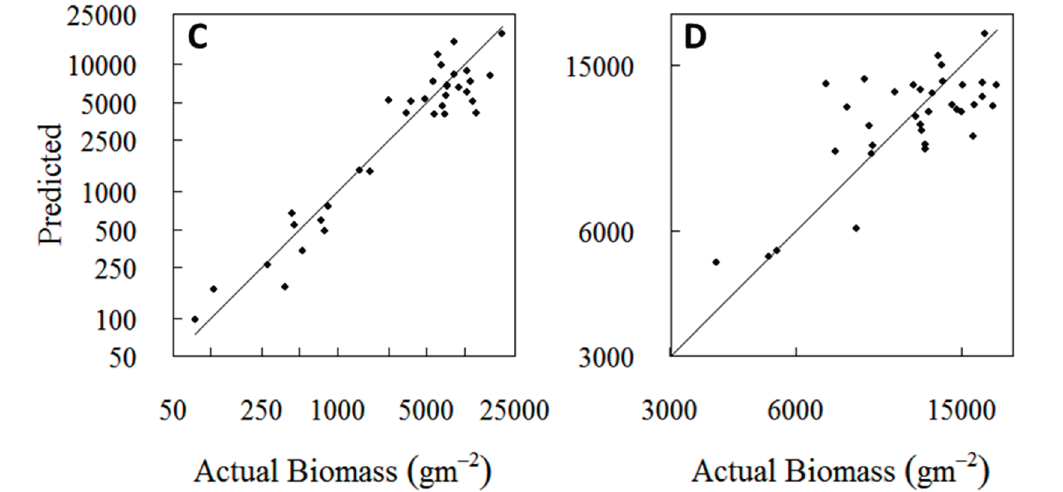
Figure 6. Scatterplots of observed (validation subset) versus predicted aboveground wet biomass using the two-band vegetation indices shaded in gray from Table 3 for rice ( A ); alfalfa ( B ); cotton ( C ); and maize ( D ). The diagonal line represents a 1:1